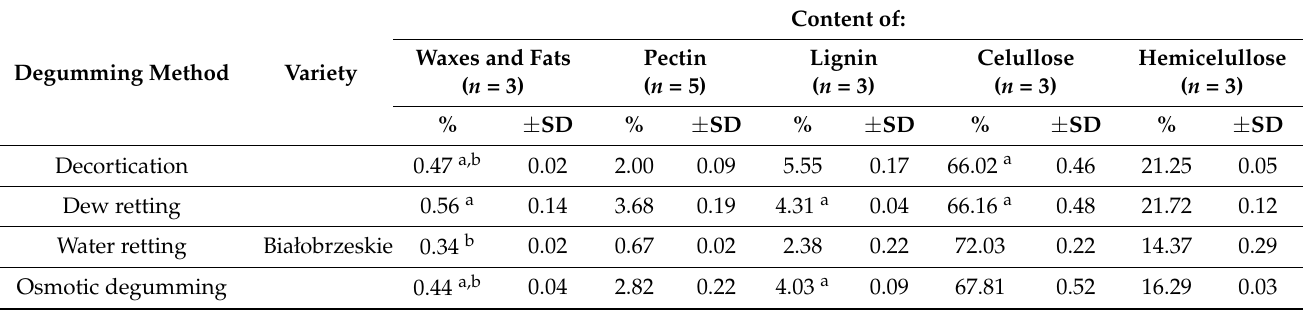
Table 8. Chemical composition of hemp fibre of the Bialobrzeskie variety after different methods of extraction: dew retting, decortication, osmotically degumming and water retting. Results are expressed as mean ± standard deviation (SD). Lowercase letters (a,b) indicate significant differences at p ≤ 0.05 according to the Tukay’s HSD test